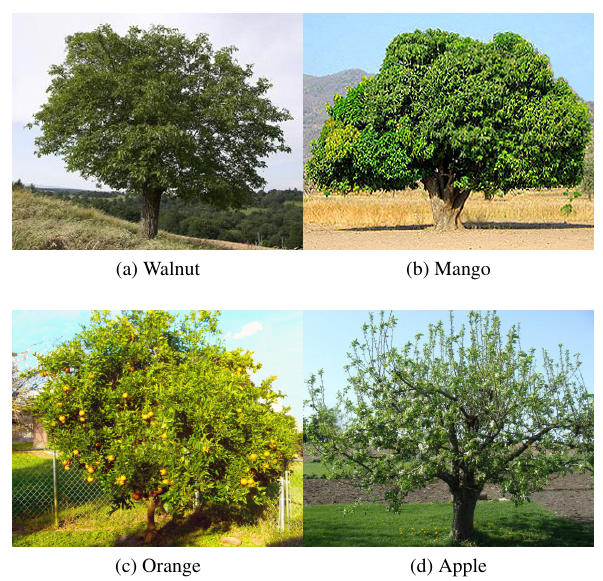
Figure 5: The different types of fruit trees analysed with the tree- counting algorithm. Note how the apple tree crown is much more open than the other three types.